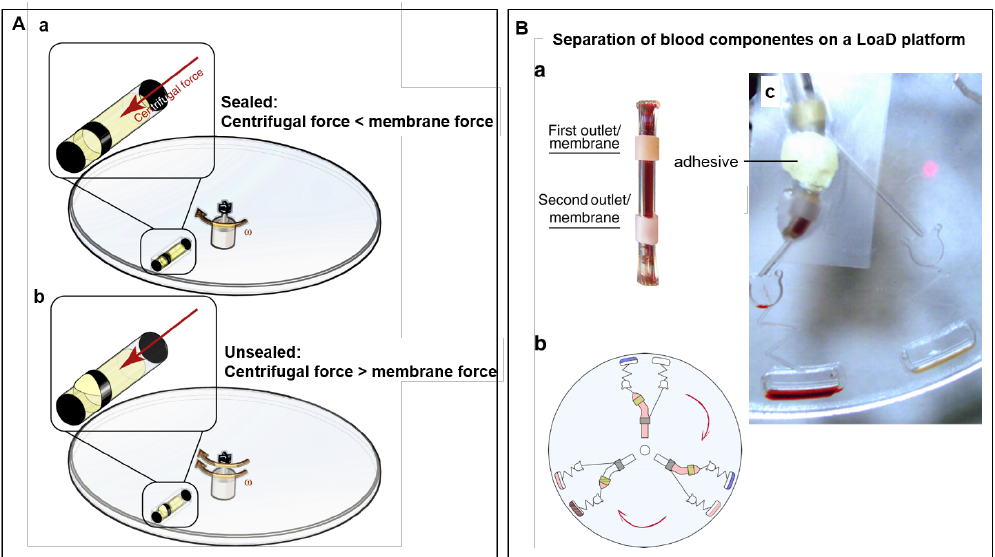
Figure 5. ( A ) Micro-dispenser working principle in a LoaD platform. ( a ) When the centrifugal force is lower than the membrane resistance, no liquid is released. ( b ) Increasing the rotation speed, the centrifugal force overcomes the membrane force and the fluid is temporary released. ( B ) Separation of blood on a LoaD platform. ( a ) Micro-dispenser with two apertures covered with two different membranes, C-flex and latex, and ( b ) a schematic of the LoaD platform for 3 identical assays for blood separation. ( c ) Picture of the disc dispensing blood plasma and blood cells to two different chambers at different rotation frequencies due to the difference in the membranes properties. Reproduced from